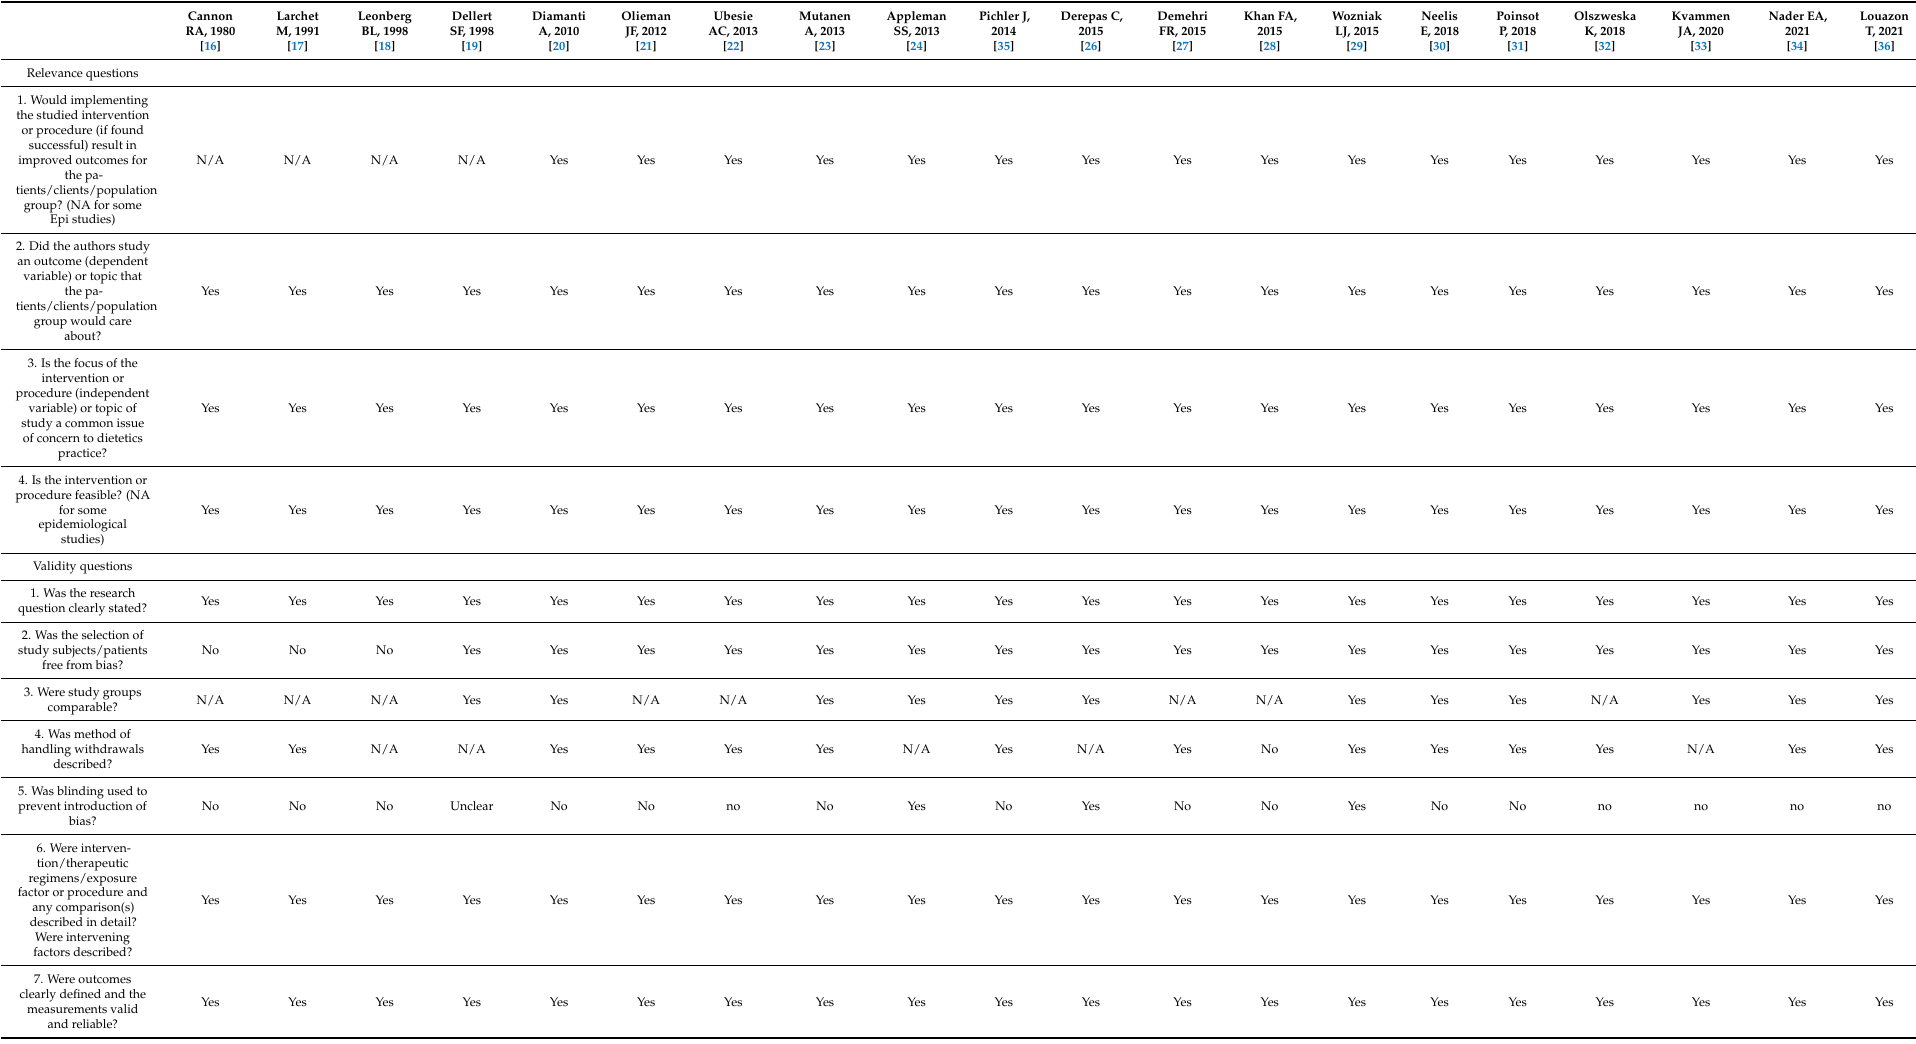
Table 1. Quality assessment results, based on Quality Criteria Checklist: Primary